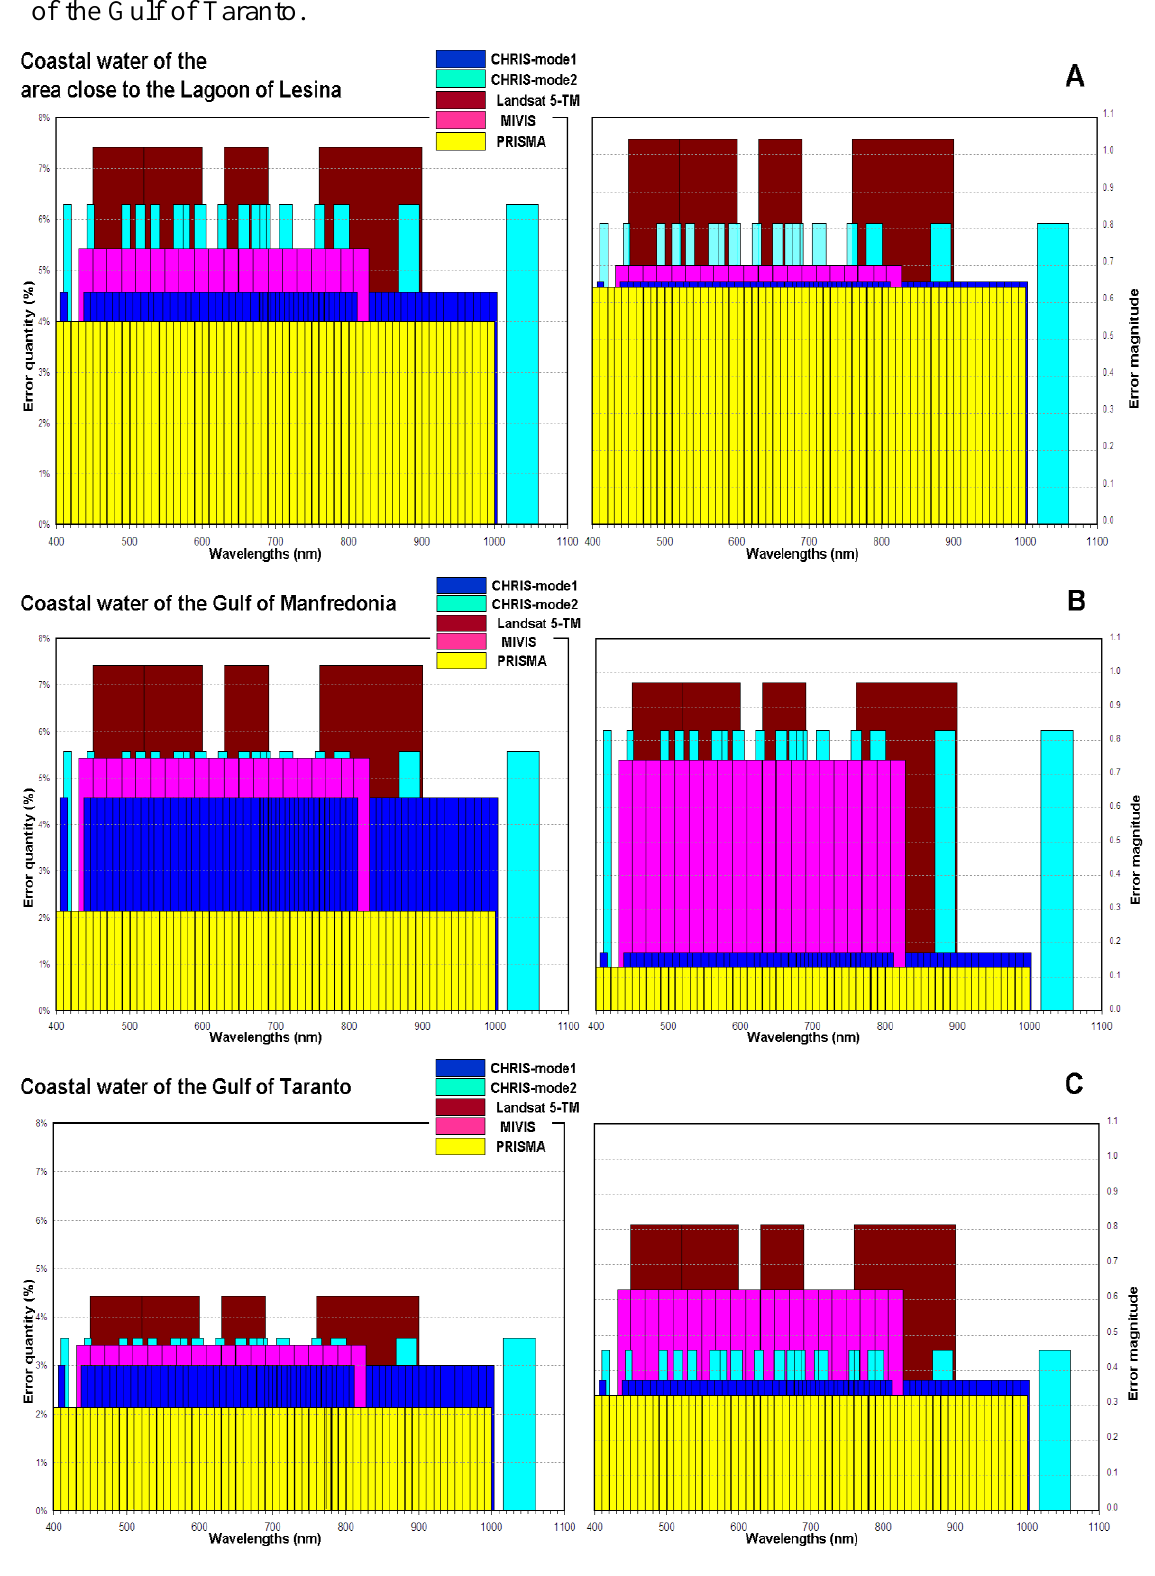
Figure 4. The error quantities ( left ) and the error magnitudes ( right ) with respect to the spectral characteristics of these data: ( A ) error quantities and error magnitudes in characterizing the coastal waters of the area close to the Lagoon of Lesina; ( B ) error quantities and error magnitudes in characterizing the coastal waters of the Gulf of Manfredonia; ( C ) error quantities and error magnitudes in characterizing the coastal waters of the Gulf of